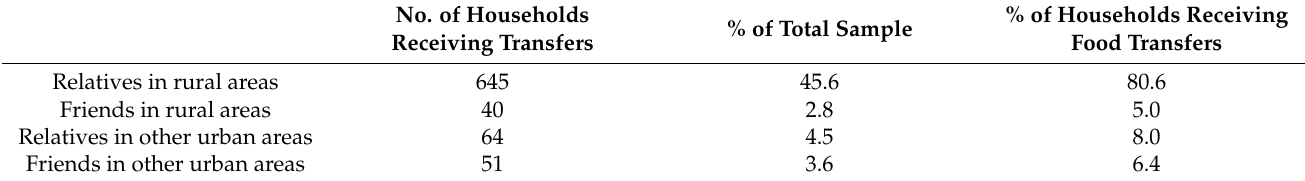
Table 2. Geographical Origin of Household Food Remittances.